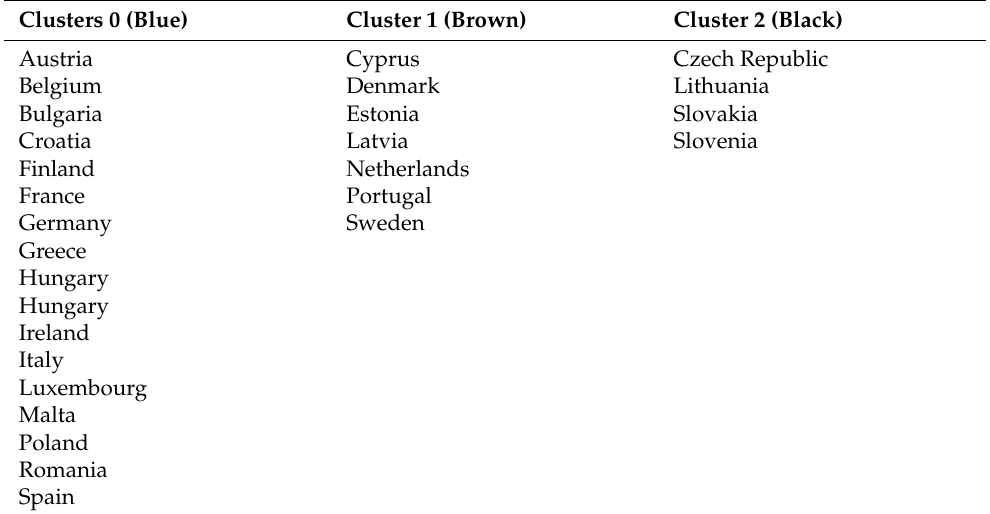
Table 6. Distribution of countries into groups in terms of COVID-19 representative indicators, K-means clustering algorithm